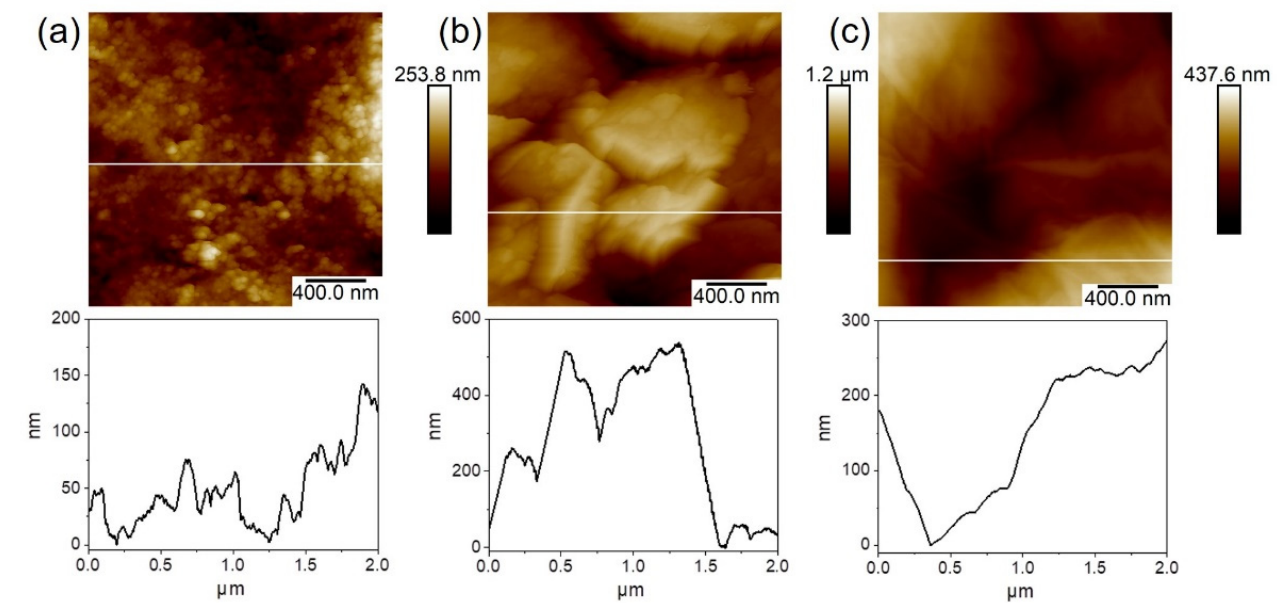
Figure 5. Non-contact-mode AFM images (2 μ m × 2 μ m) on: ( a ) GL film; ( b ) GO-GRA film; ( c ) GO-SA film. Images show a reference line fixed at 2 μ m to highlight film surface roughness (lower pan- els).